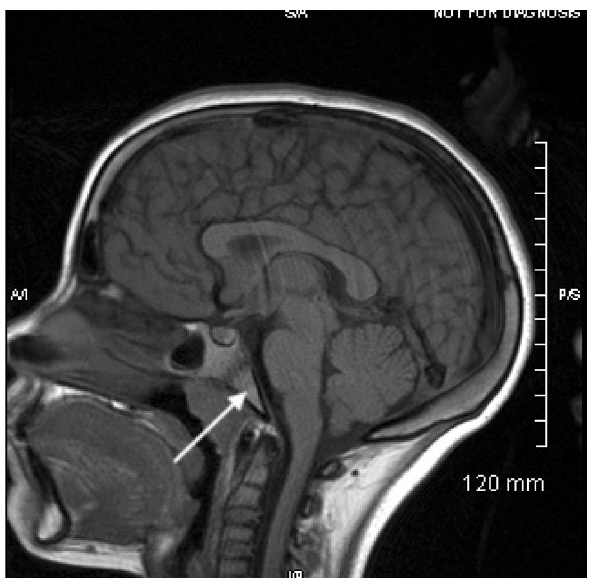
Fig. 4 The visualized osseous structures have a high T1